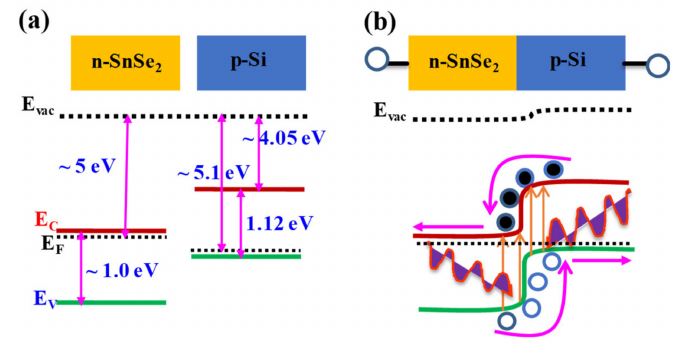
Figure 5. ( a , b ) A Energy band diagram of n-SnSe 2 and p-Si before at equilibrium. At equilibrium, the Fermi levels of n- and p-side line up as shown by the dashed lines. The absorption of a photon with energy h ν ≥ band gap will generate electron-hole pairs. The electron-hole pairs are then separated and accelerated by the built-in electric field at the junction. ( a , b ) are reproduced with permission from reference